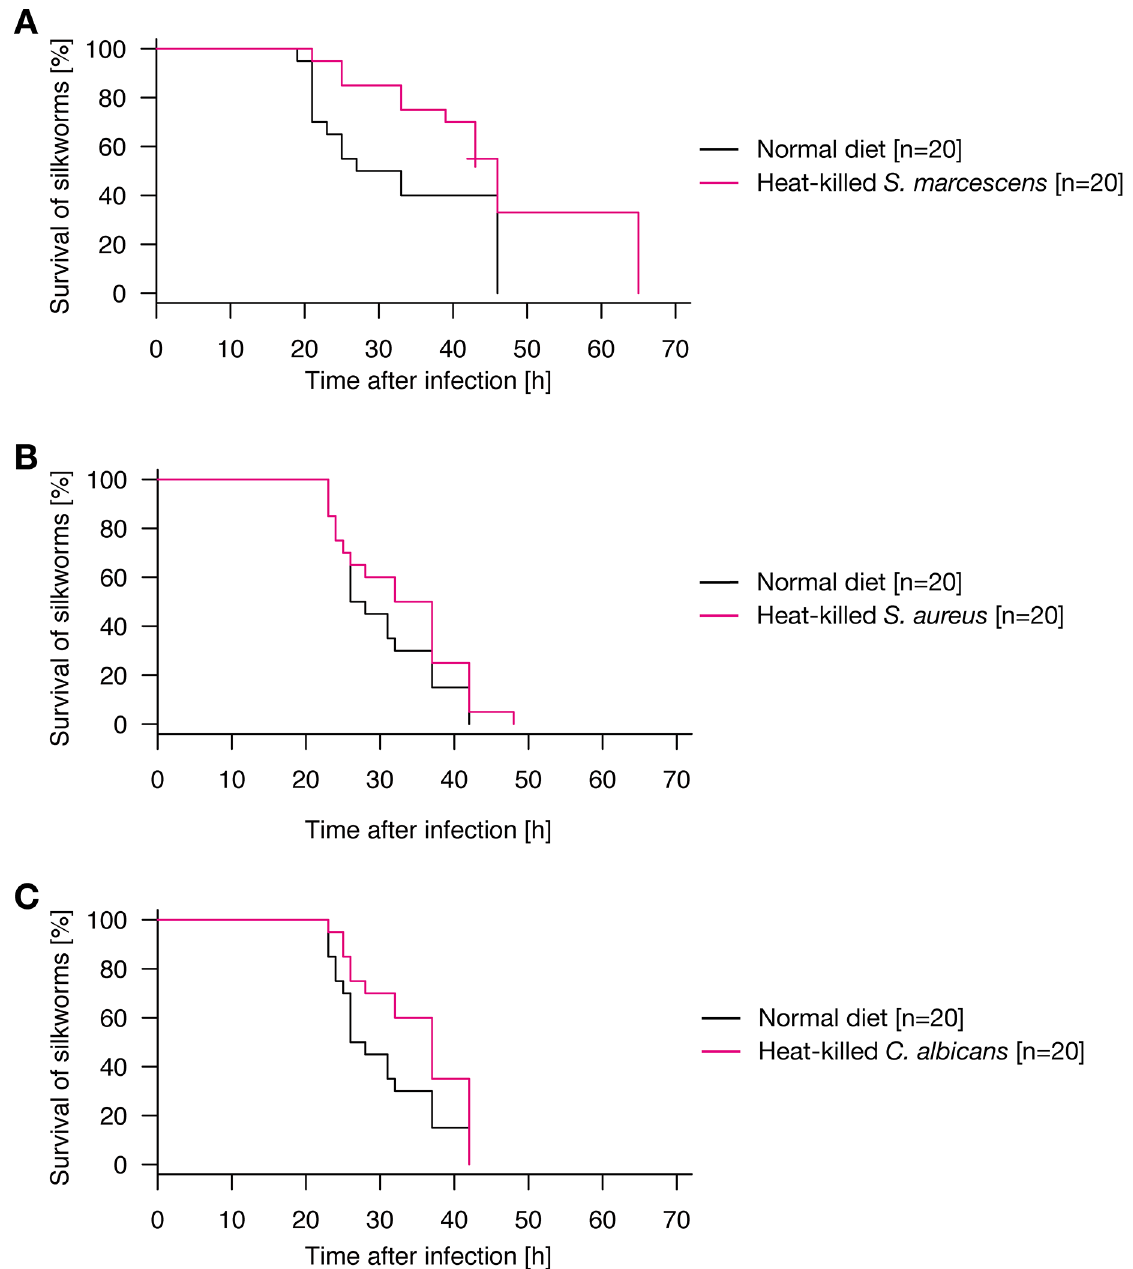
Fig 2. Resistance of silkworms orally administered with heat-killed cells of various microorganisms against P . aeruginosa infection. A. Silkworms were fed a normal diet (n = 20) or a diet containing heat-killed cells of S . marcescen s (n = 20) for 2 d, and then infected with P . aeruginosa in hemolymph. Results from two independent trials (S1 Table, exp. 3 – 4) were combined into a single analysis. The combined survival curve is shown in the figure. Survival of silkworms fed a diet containing heat-killed S . marcescens cells was significantly higher than that of silkworms fed a normal diet (p = 0.0219). None of the mock-infected silkworms died (S1 Fig). B. Silkworms were fed a normal diet (n = 20) or a diet containing heat-killed S . aureus cells (n = 20) for 2 d, and then injected with P . aeruginosa . Results from two independent trials (S1 Table, exp. 5 – 6) were combined into a single analysis. The combined survival curve is shown in the figure. Survival of silkworms fed a diet containing heat-killed S . aureus cells was not significantly different from that of silkworms fed a normal diet (p = 0.235). None of the mock-infected silkworms died (S1 Fig). C. Silkworms were fed a normal diet (n = 20) or a diet containing heat-killed C . albicans cells (n = 20) for 2 d, and then injected with P . aeruginosa . Results from two independent trials (S1 Table, exp. 5 – 6) were combined into a single analysis. The combined survival curve is shown in the figure. Survival of silkworms fed a diet containing heat-killed C . albicans cells was significantly higher than that of silkworms fed a normal diet (p = 0.0494). None of the mock-infected silkworms died (S1 Fig).